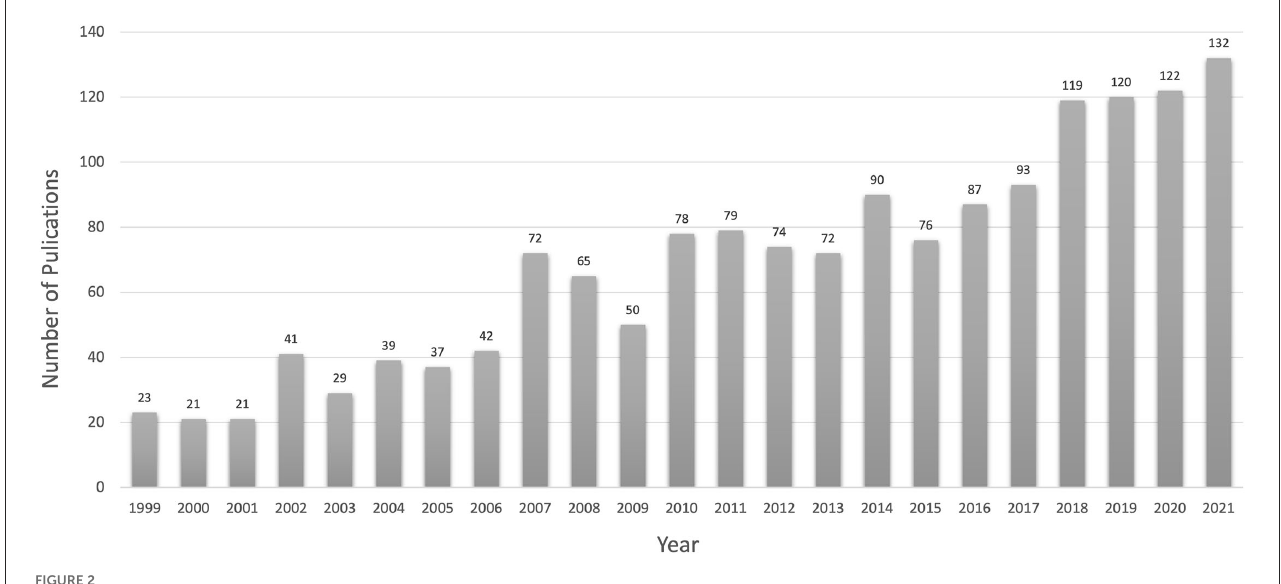
FIGURE2 The number of articles published has grown steadily and peaked in